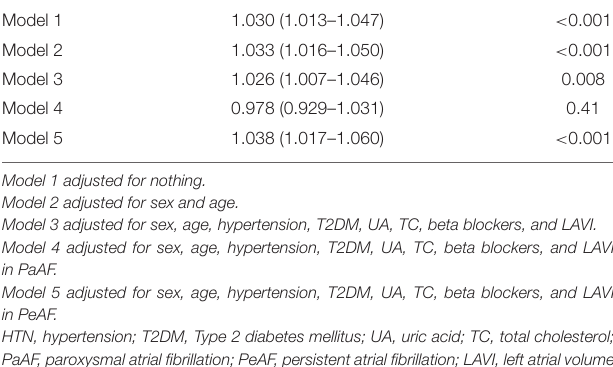
TABLE 6 | Associations between sST2 and AF recurrence by Cox Regression. HR (95% CI) P